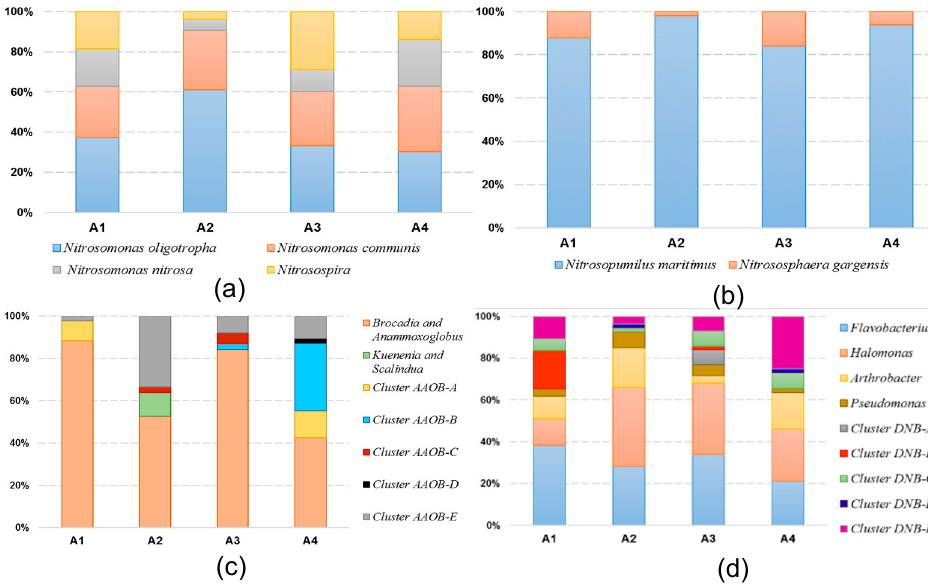
Figure 4. The relative abundance of ( a ) AOB amoA gene, ( b ) AOA Arch - amoA gene, ( c ) AAOB hzo gene, and ( d ) DNB nirS gene clone libraries at four regions.